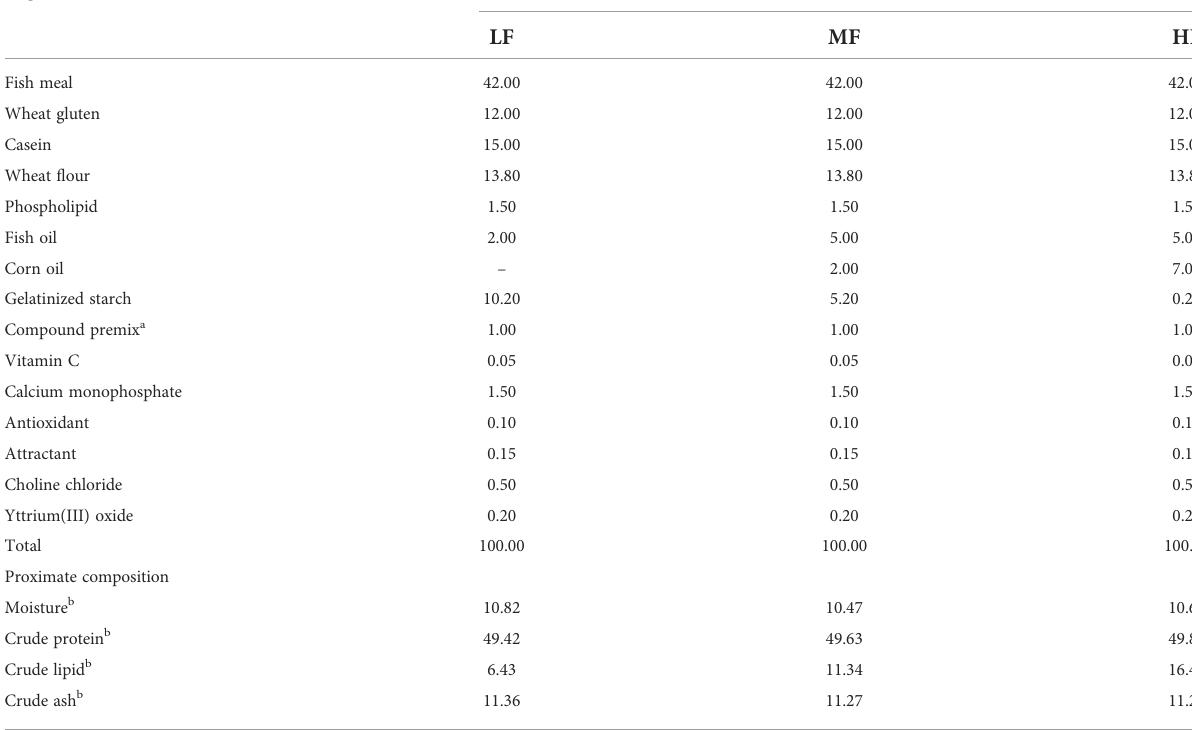
TABLE 1 Feed formulation and nutrient content of the test diets (% dry